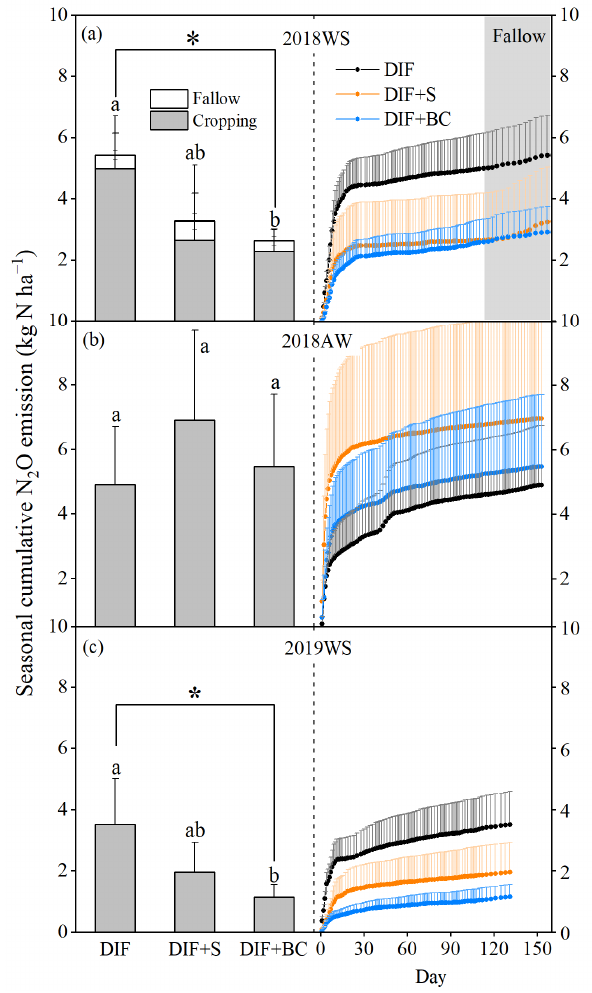
Figure 2. Cumulative seasonal N 2 O emissions for 2018WS ( a ), 2018AW ( b ) and 2019WS ( c ) for the three different treatments. Following the 2018WS growing season, measurements of soil N 2 O fluxes also continued during the fallow period (52 days). DIF: drip fertigation; DIF+S: drip fertigation with straw incorporation; DIF+BC: drip fertigation with biochar incorporation. * indicates significant difference between treatments ( p < 0.05, n = 3). Different lowercase letters indicate significant difference amongst three treatments ( p < 0.05, n = 3). Error bars represent the standard error ( n = 3).